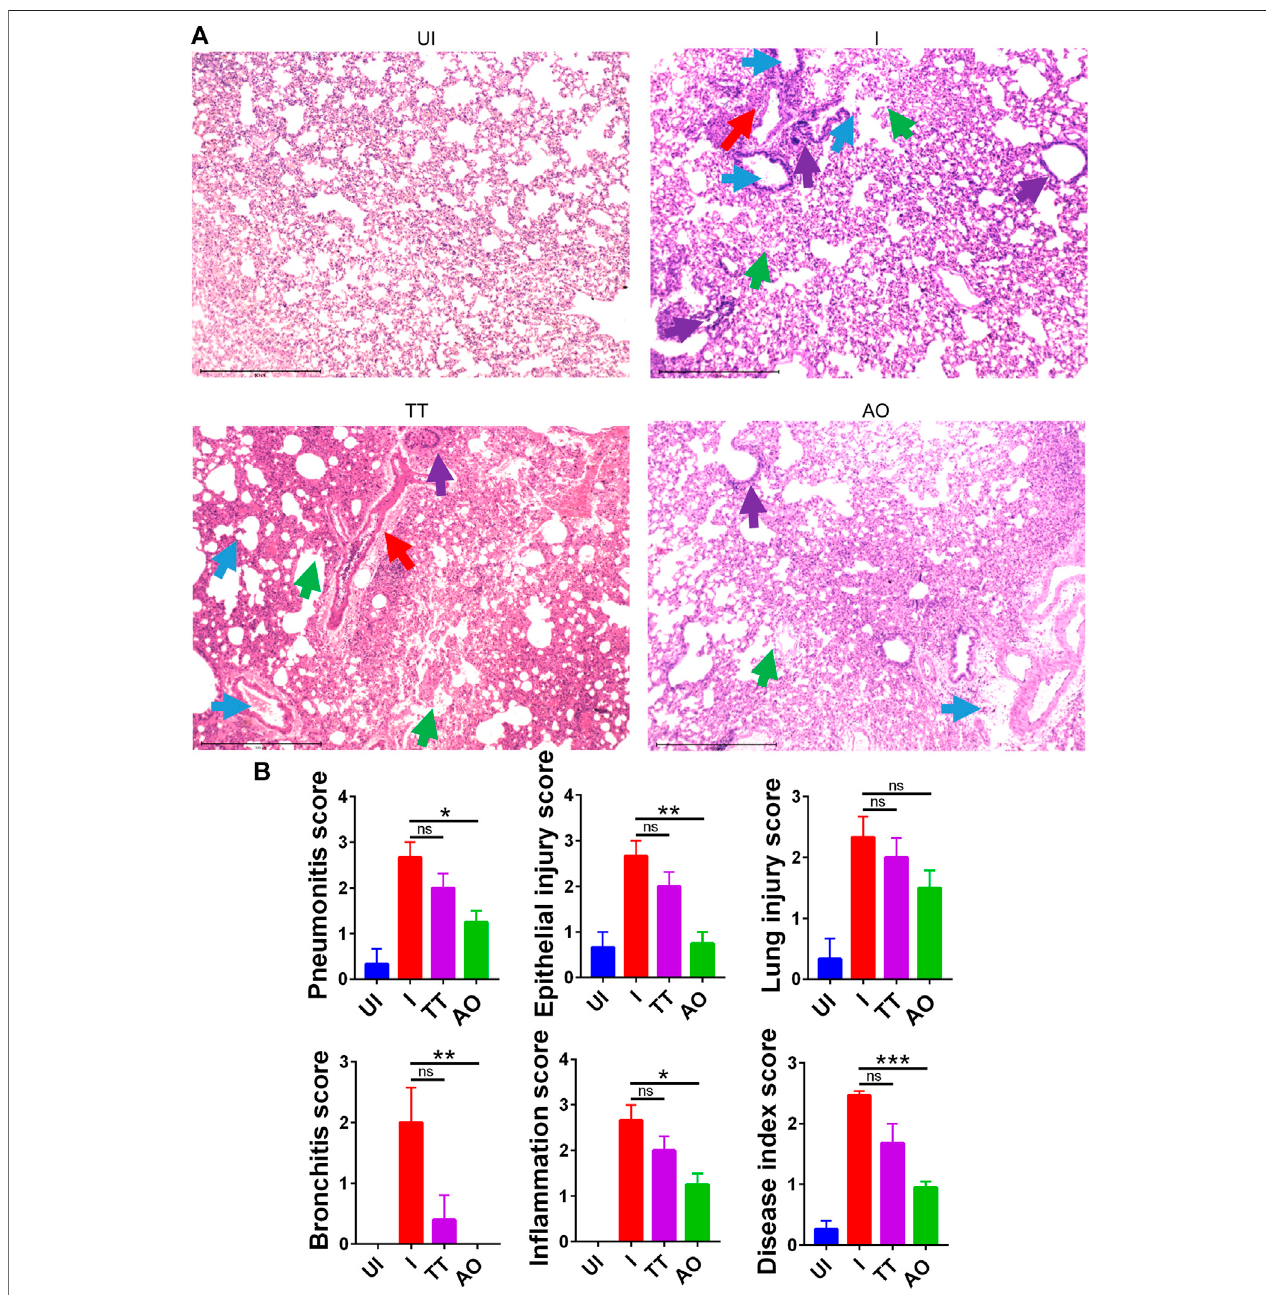
FIGURE 2 | H&E – stained lung sections showing histopathology and its assessment. (A) images of H&E-stained lungs at × 40 magni fi cation showing regions of pneumonitis (blue arrow), bronchitis (red arrow), epithelial injury (green arrow), and in fl ammation (purple arrow) along with their (B) histological score for pneumonitis, in fl ammation, lung injury, alveolar epithelial cells, bronchitis, and overall disease score for different groups UI, I, TT, and AO on day 4 postinfection. * p < 0.05, ** p < 0.01, *** p < 0.001 (one-way ANOVA).